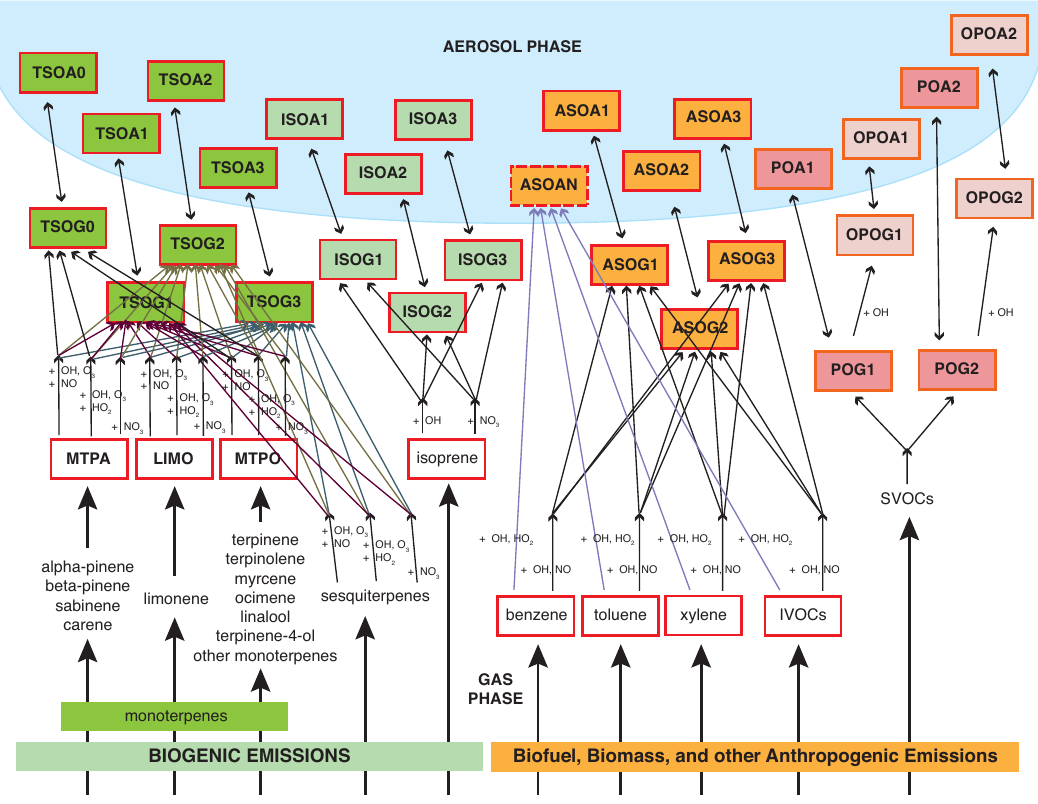
Fig. 1. Schematic of SOA model. Species appearing in boxes are tracers. A bidirectional arrow across the aerosol/gas interface indicates a semivolatile species. ASOAN is nonvolatile. SOA/G0-3 species have saturation concentrations of 0.1, 1, 10, 100µg/m 3 . SVOCs are represented using an Odum 2-product fit. Yield parameters are shown in Table 1. For a traditional simulation, IVOCs are not emitted and nonvolatile POA replaces the